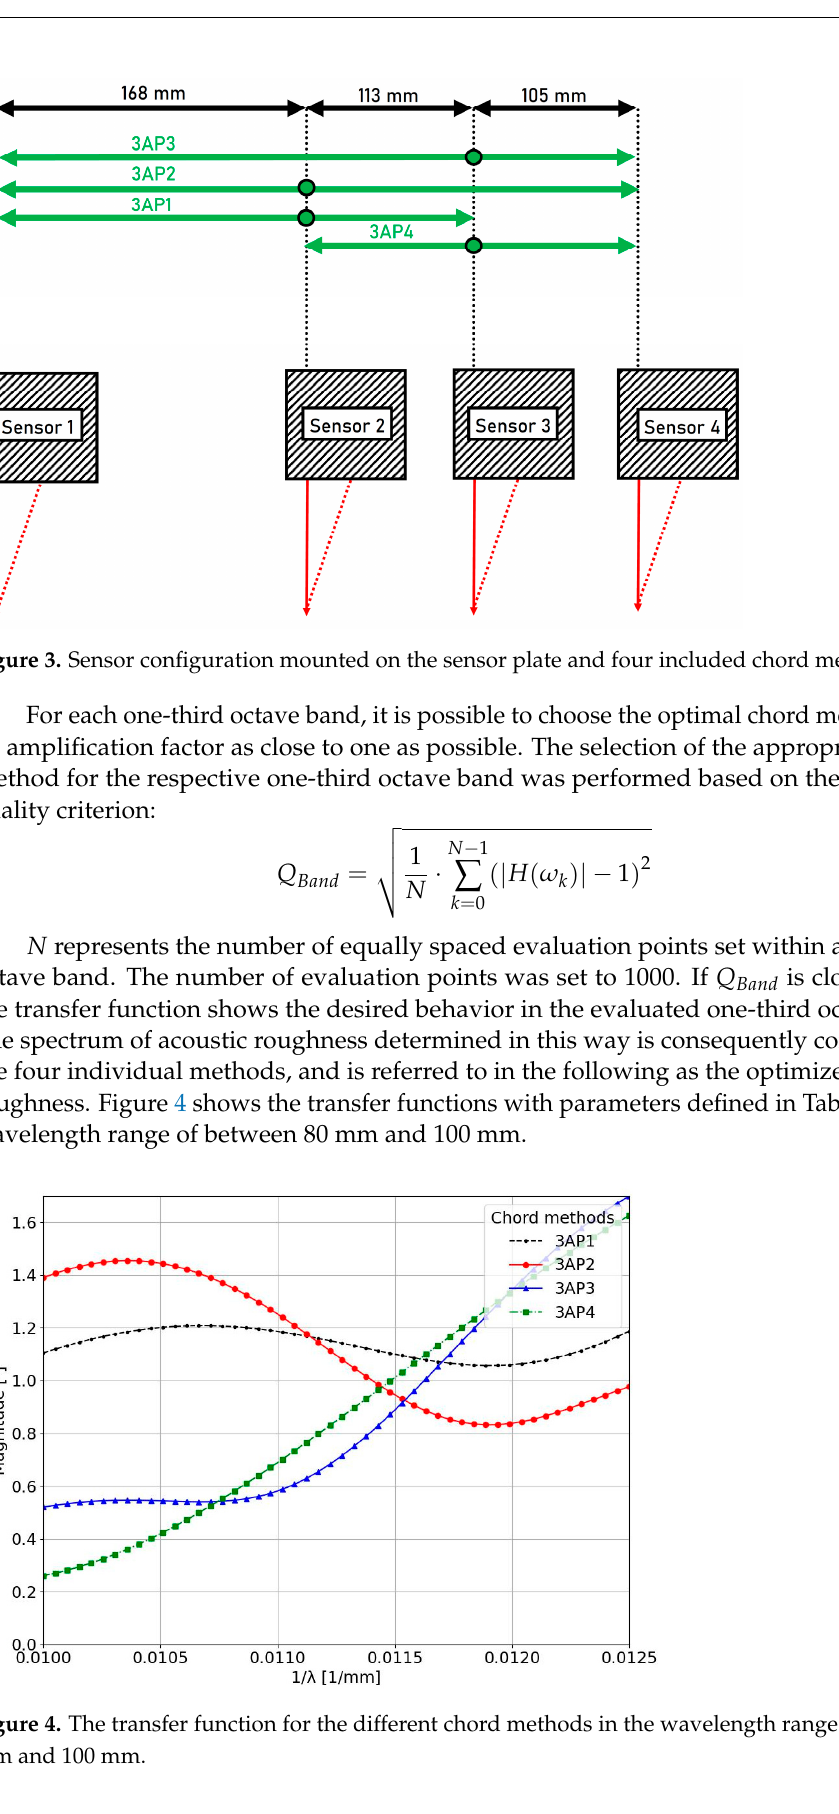
Figure 4. The transfer function for the different chord methods in the wavelength range between 80 mm and 100 mm .